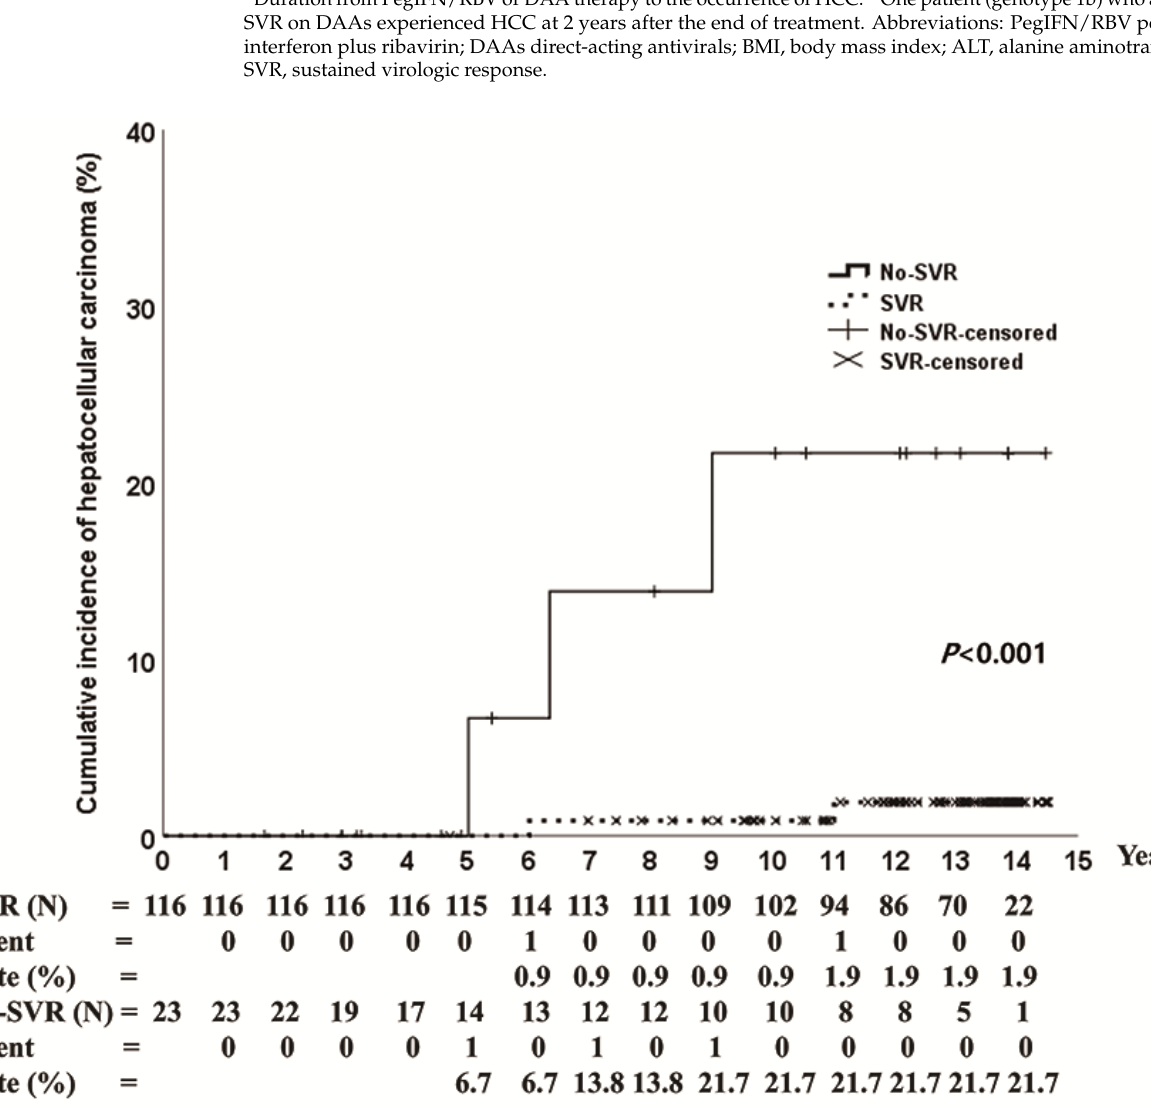
Figure 4. Cumulative incidence of hepatocellular carcinoma according to treatment response with pegylated interferon plus ribavirin. SVR, sustained virological response; No-SVR, no sustained vi- rological response. Table 2. Clinical characteristics of patients with newly developed hepatocellular carcinoma after antiviral therapy.